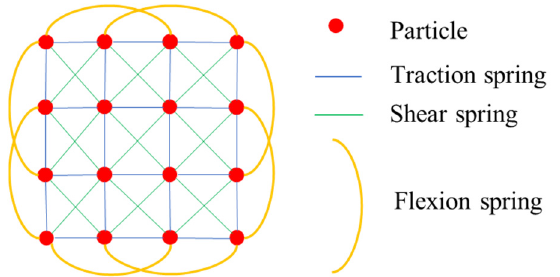
Figure 2. Cloth grid simulated in a computer program. Flexion springs resist bending stresses; sheer springs resist sheering stresses; traction springs resist stretching stresses . springs resist sheering stresses; traction springs resist stretching